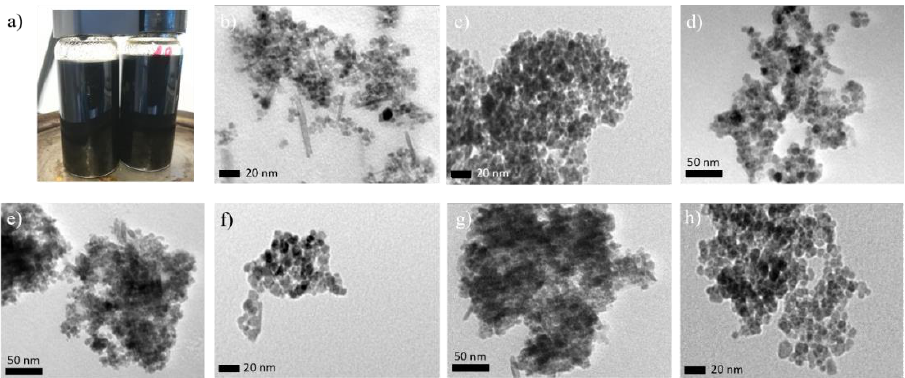
Figure 3. ( a ) Picture of the SPIONs synthesized and TEM images of the samples ( b ) 3, ( c ) 3W, ( d ) 5B, ( e ) 5, ( f ) 5W, ( g ) 5M and ( h ) CoP5.